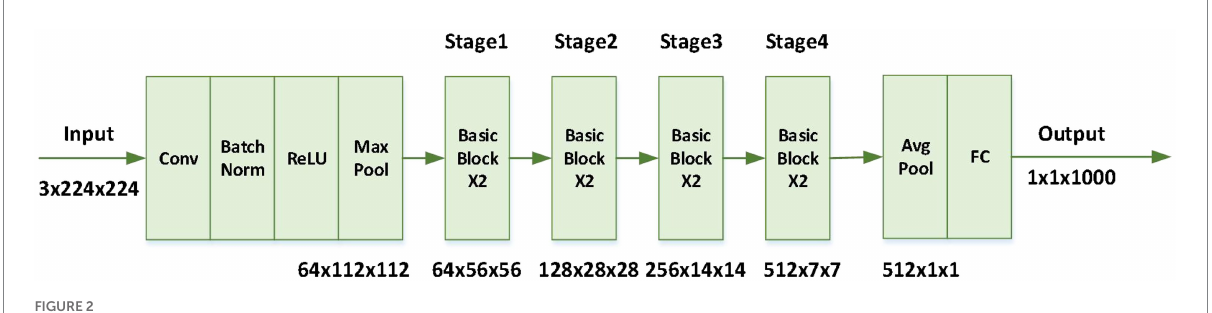
FIGURE 2 Network structure of